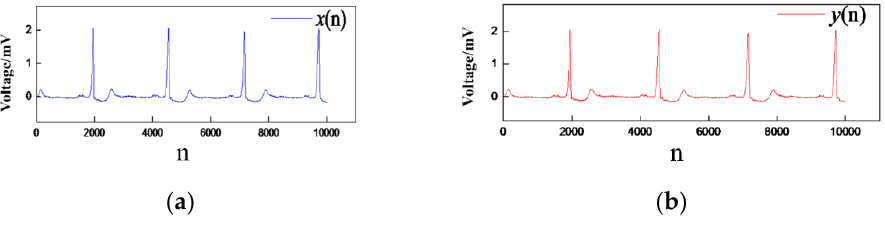
Figure 9. ( a ) Original signal; ( b ) Reconstructed signal.